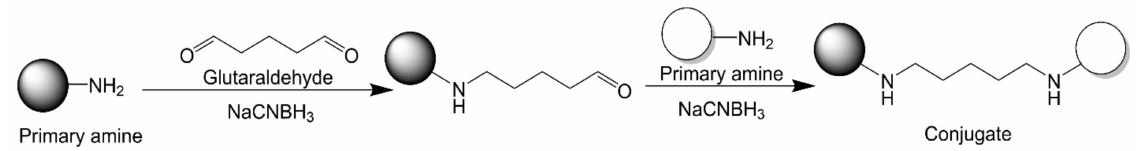
Figure 7. Glutaraldehyde